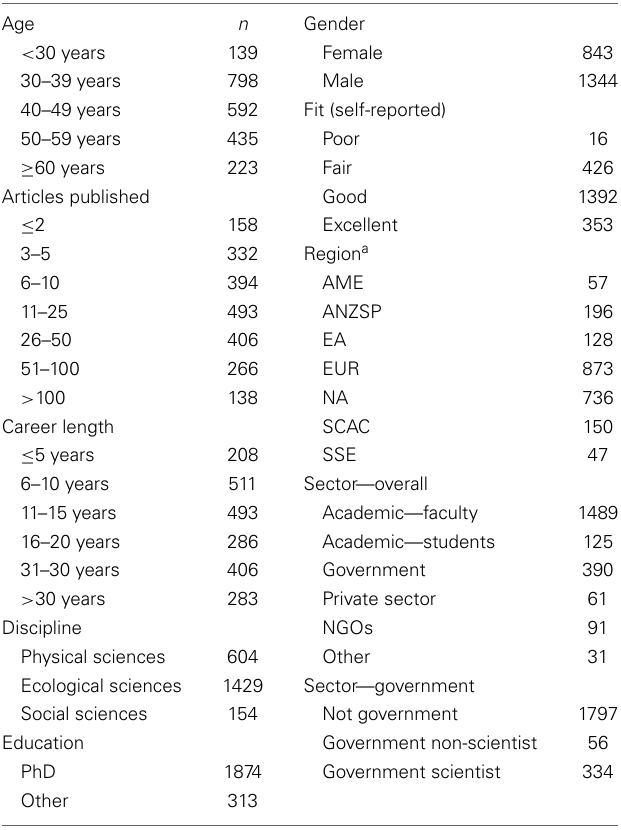
Table 2 | Demographic characteristics of survey